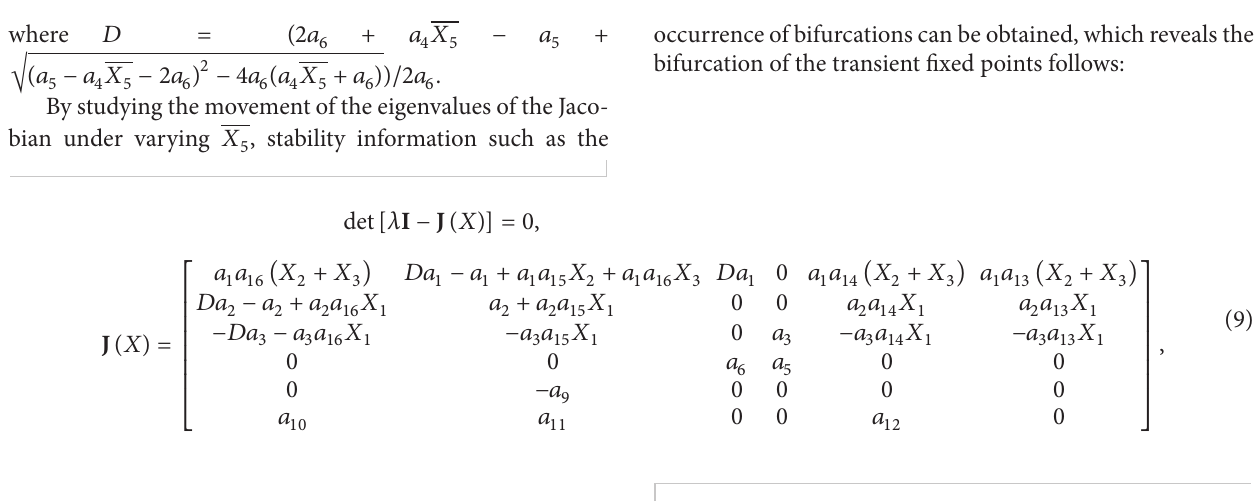
= 5 V, (b) 𝑉 = 10 V, and (c) 𝑉 ref ref